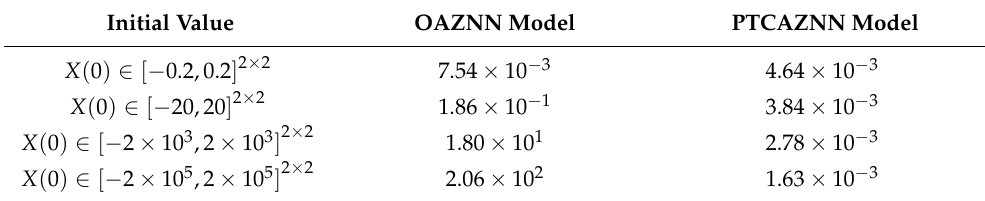
Figure 11. Dynamic characteristics of OAZNN (11) and PTCAZNN (15) when Γ = 1000 and f = 0.01. With ( a ) X ( 0 ) ∈ [ − 0.2,0.2 ] 2 × 2 ; ( b ) X ( 0 ) ∈ [ − 20,20 ] 2 × 2 ; ( c ) X ( 0 ) ∈ [ − 2 × 10 3 ,2 × 10 3 ] 2 [ − 2 × 10 5 ,2 × 10 5 ] 2 × 2 . Table 4. Upper bound of error (cid:107) E ( t ) (cid:107) F of the OAZNN model and PTCAZNN model at different initial